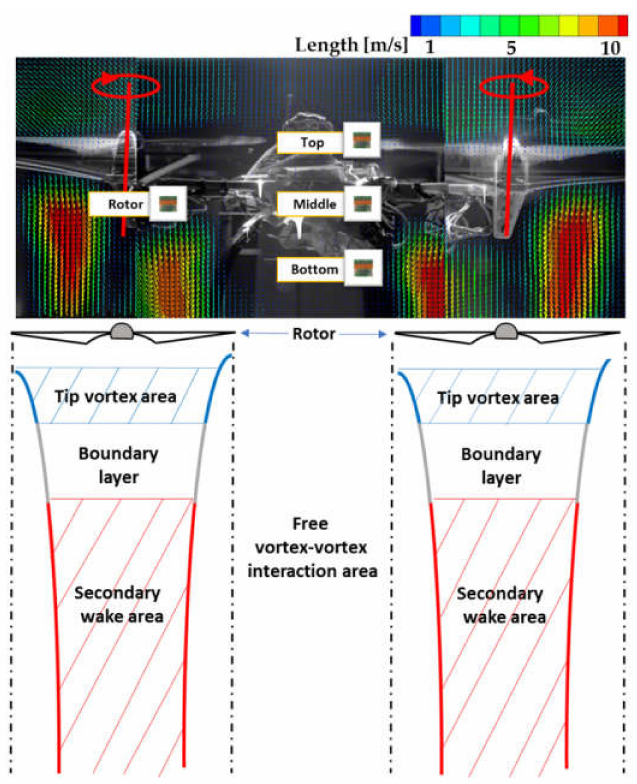
Figure 7. Vortex phenomena caused by the di ff ering flow rates in two adjacent sections under the rotor blades. Although the tip vortex area and boundary layer seem to be fairly thick from the illustration, they are actually very thin, and the secondary wakes constitute most of the flow profiles. Also, based on the present PIV measurements, we selected four possible sensor locations (Rotor, Top, Middle and Bottom) on a